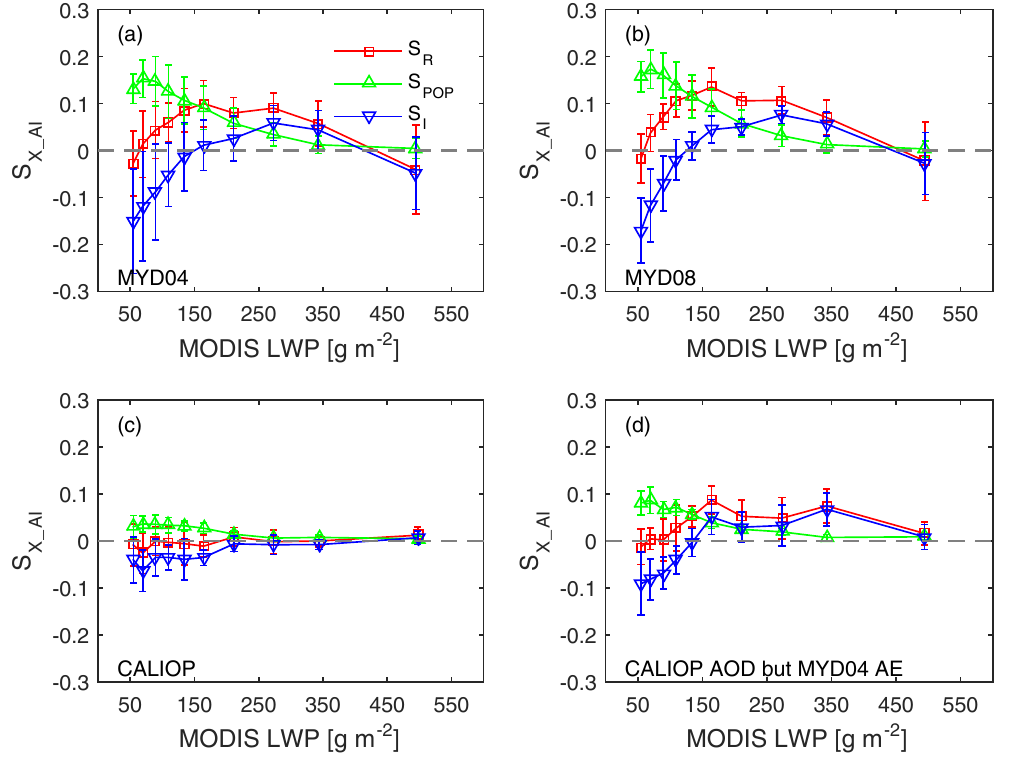
Figure 4. Susceptibilities ( S X_AI ) as a function of MODIS LWP. The rain product used is the same as that in Fig. 1. AI is derived from (a) MYD04/MODIS, (b) MYD08/MODIS, and (c) CAL_LID_L2_05kmALay/CALIOP products. Panel (d) is the same as (c) but using MYD04 AE.